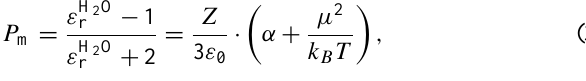
Figure 2. Humidity sensor on printed circuit board with the capac- itance measurement chip